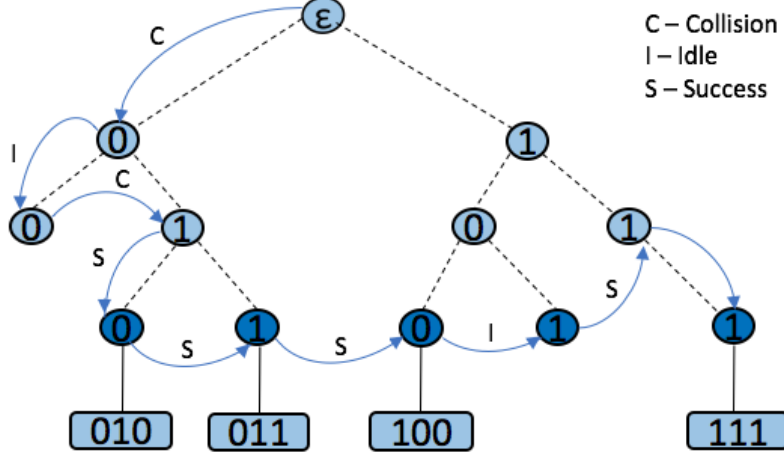
Figure 13. An example of STT protocol.